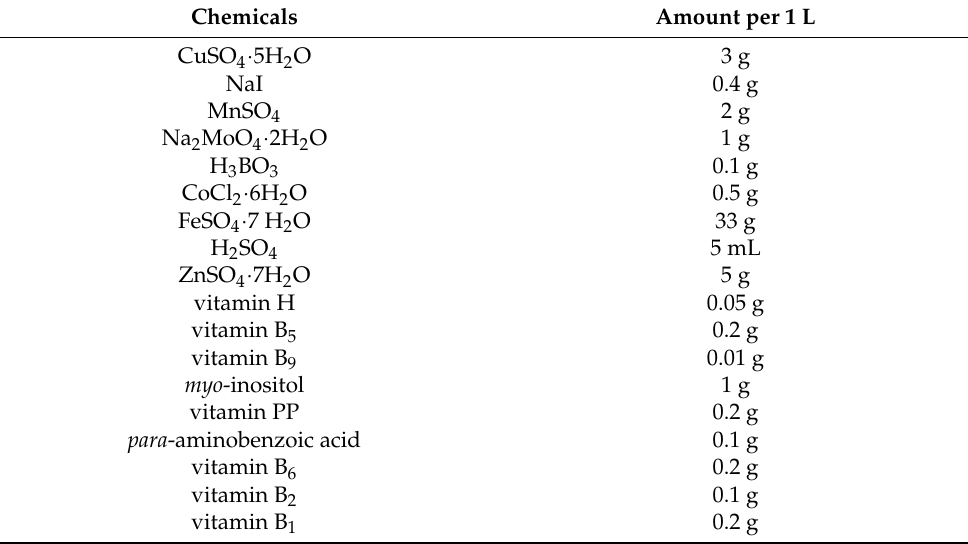
Table 1. Amount of added chemicals in 5 L of